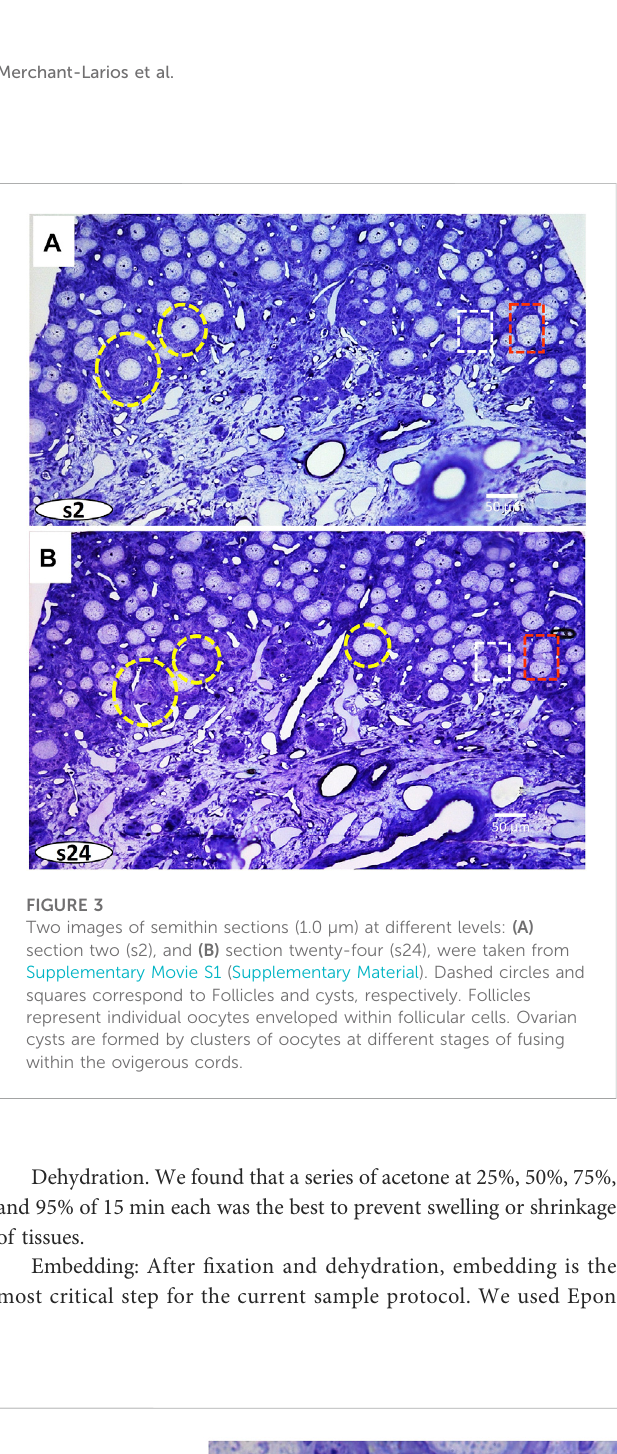
Frontiers in Cell and Developmental